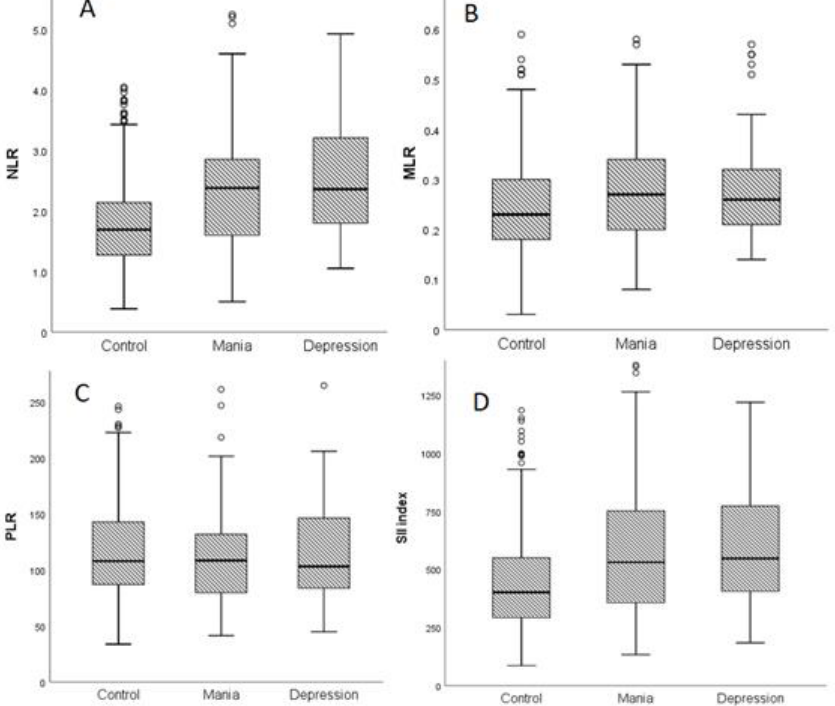
Figure 1. Distribution of inflammatory ratios, ( A ) neutrophil-to-lymphocyte ratio (NLR), ( B ) mono-